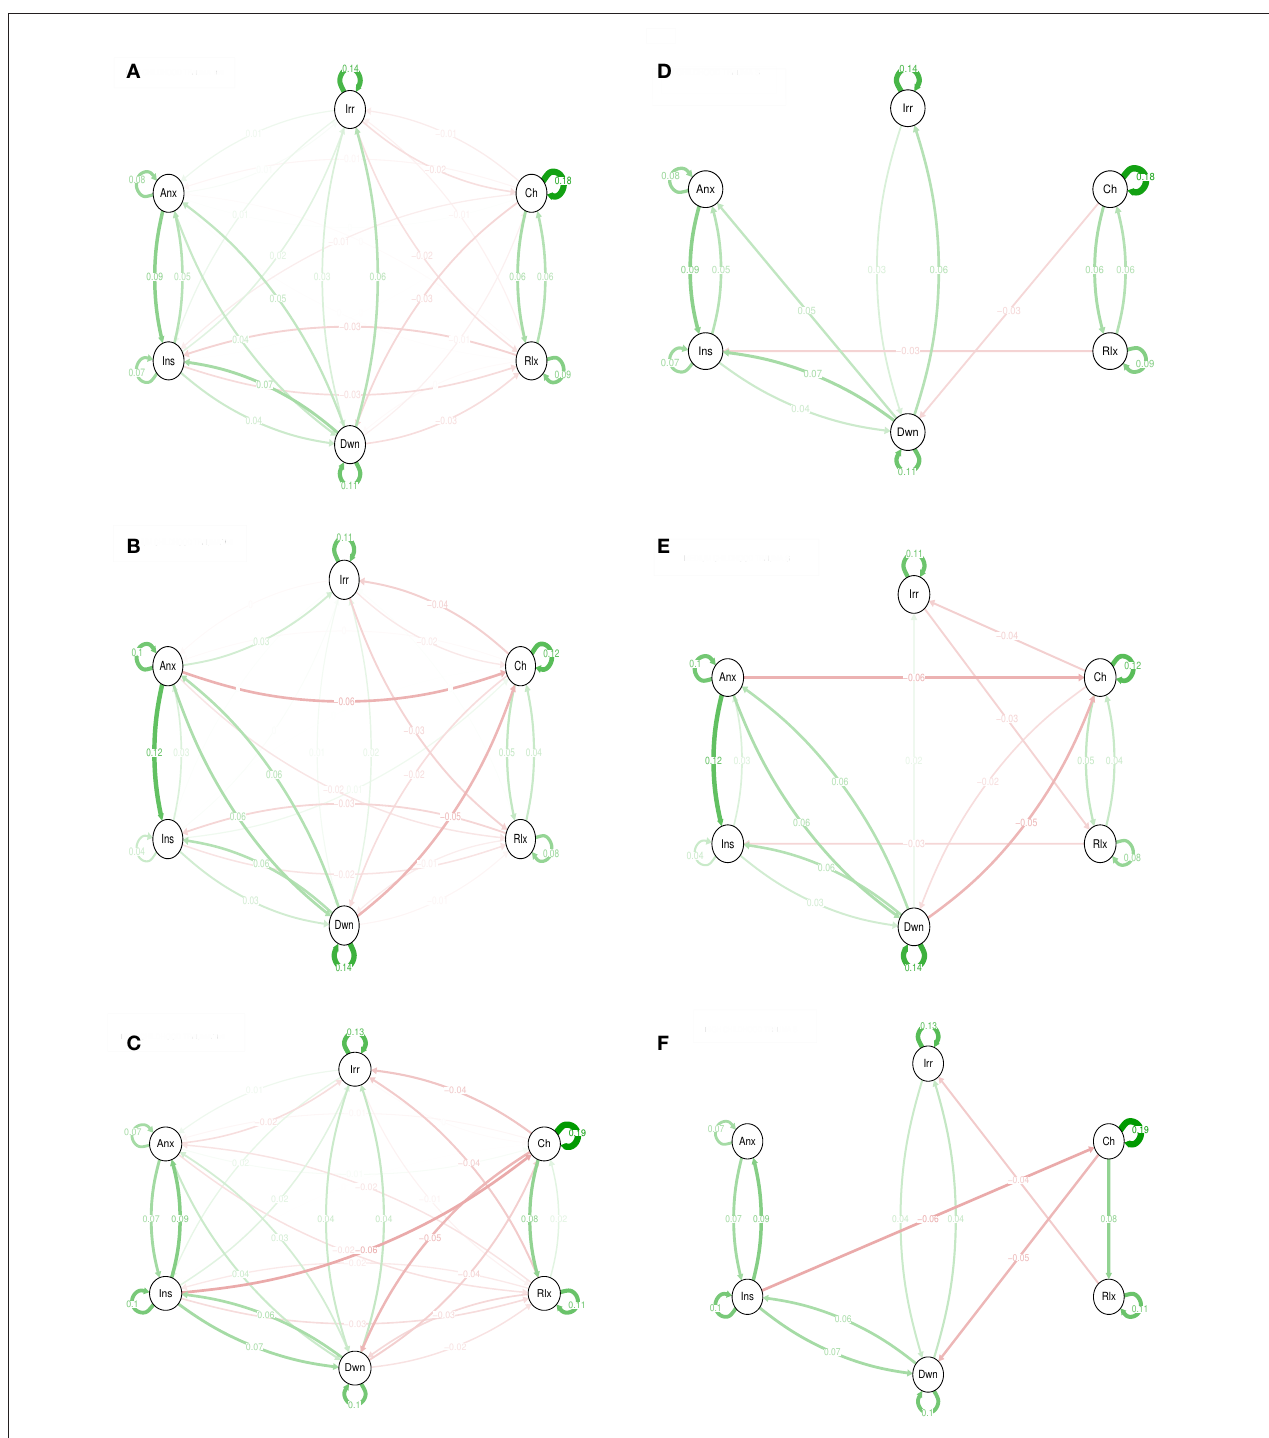
FIGURE 1 | Emotions networks in subjects with low, medium, and high levels of childhood trauma. In this figure, the arrows represent associations over time; i.e., the B coefficient expressing the effect size of the predictive associations. For example, in the low CT network, there is an arrow from “relaxed” to “cheerful,” meaning that “relaxed” at t − 1 predicts “cheerful” at t with a B coefficient of 0.06. Green arrows represent positive associations, and red arrows represent negative associations. The fading of the lines represents the strength of the association and are determined by the regression weights: the more solid the line, the stronger the association (and vice versa). Note that we can predict the emotion item from the previous state of the item itself. These arrows are the self-loops in the network. CT, childhood trauma. Graphs (A–C) are for low, medium, and high CT respectively. The Graphs (D–F) are for low, medium, and high CT respectively but only with associations that resisted to Simes correction for multiple testing with p <